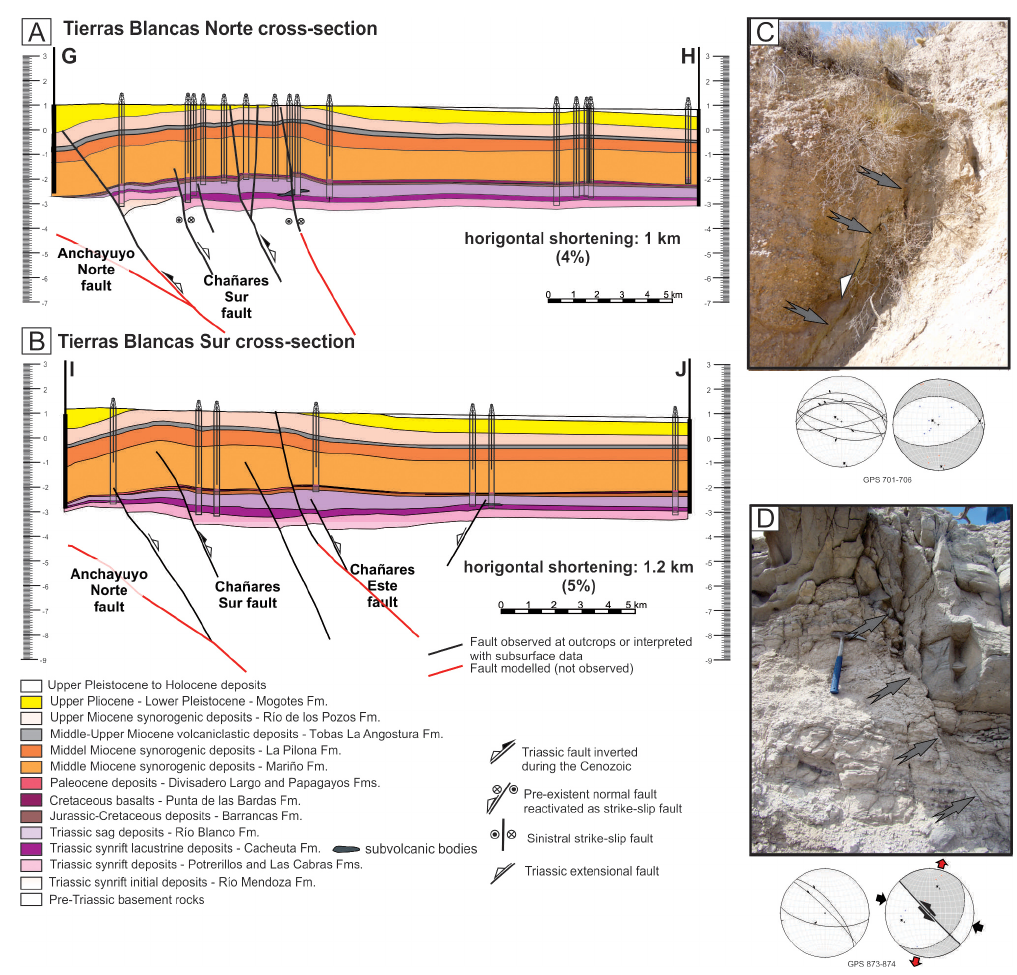
Figure 8. Tierras Blancas Norte (a) and Tierras Blancas Sur (b) cross sections. See location in Fig. 4. (c) Photograph looking east of a mesoscopic normal fault and kinematic data measured along cross sections. (d) Photograph looking SE and kinematic data of the T7 fault, mapped by Stahlschmidt (1985) as a normal–strike-slip